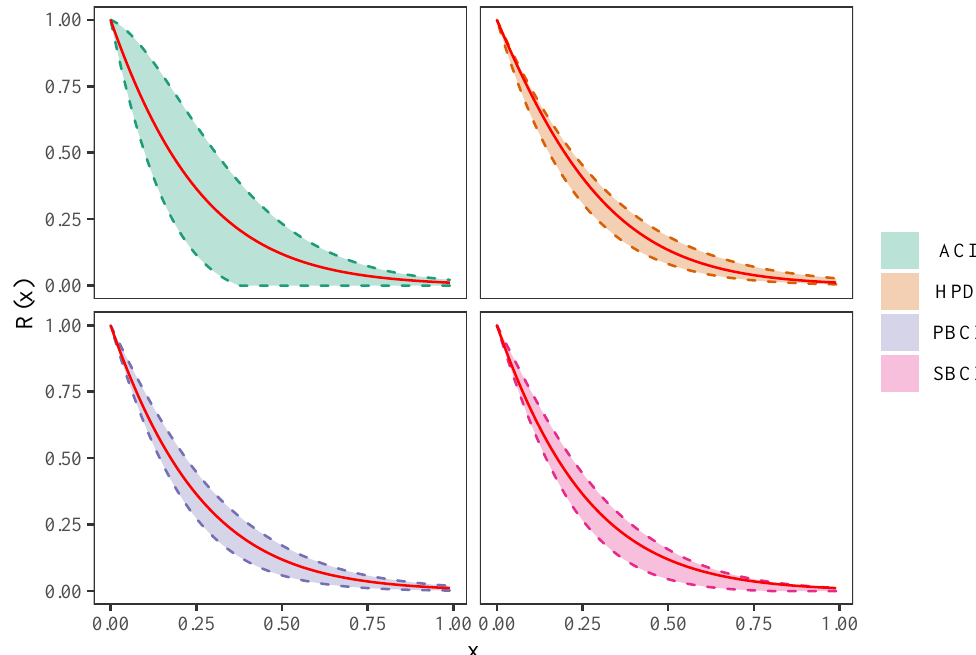
Figure 4. Interval estimates of RF R ( x ) where the true values of R ( x ) are marked in